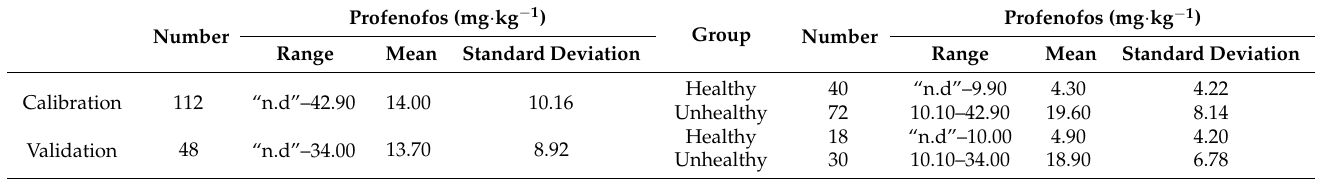
Table 3. Reference values (mean, standard deviation (SD), and range) for the content of profenofos (mg · kg − 1 ).